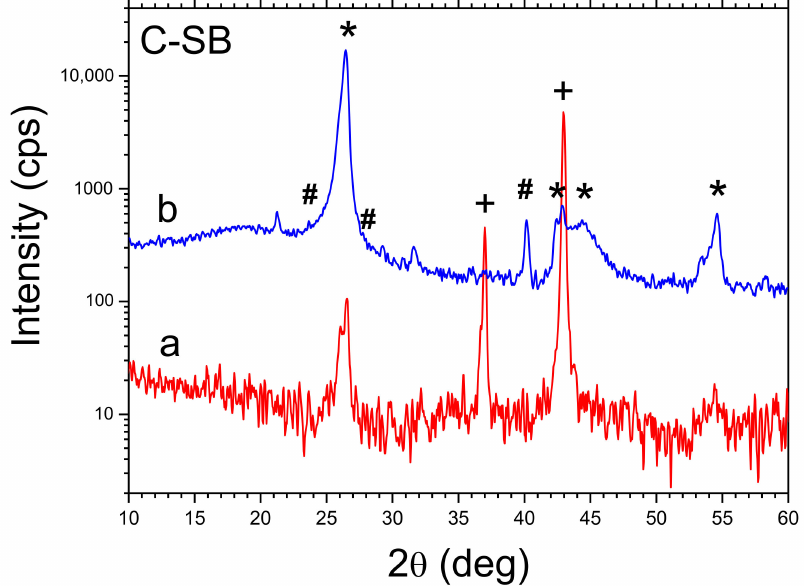
Figure 1. XRD patterns of C-SB (sodium bicarbonate), a—raw reaction product, b—cleaned. Symbols: * graphite, + MgO, # Mg 2